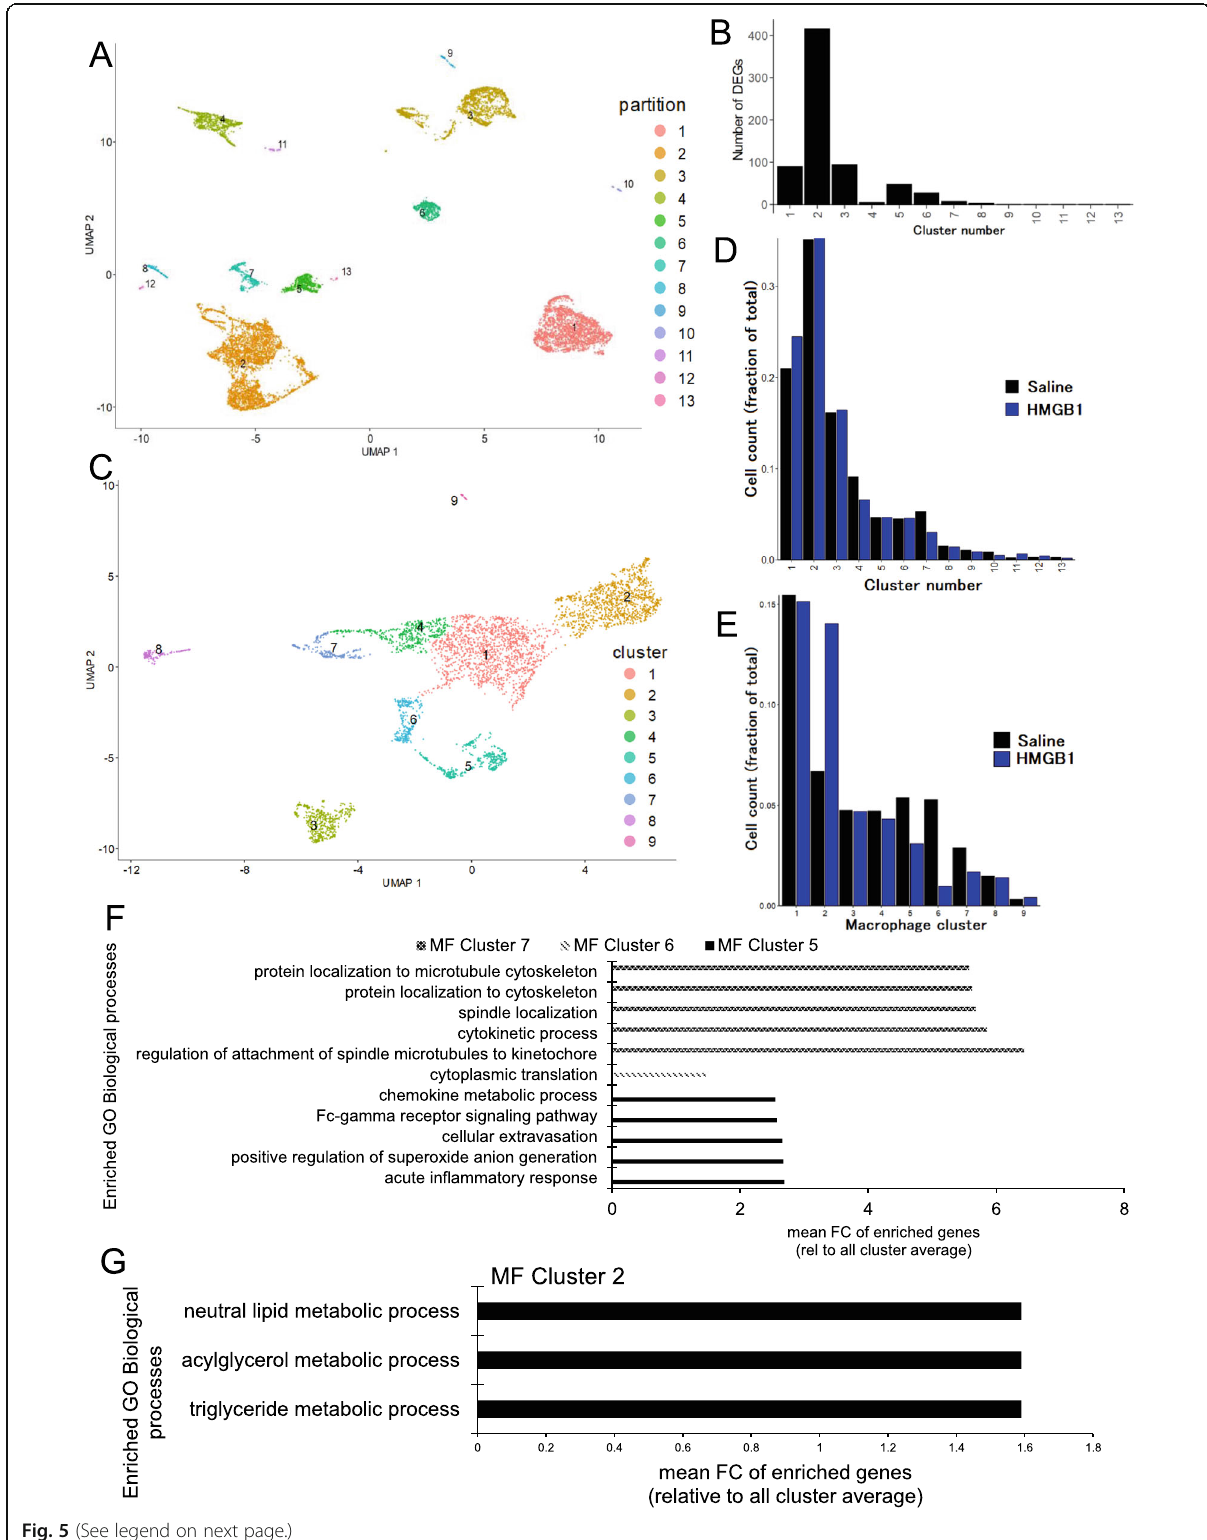
Fig. 5 (See legend on next